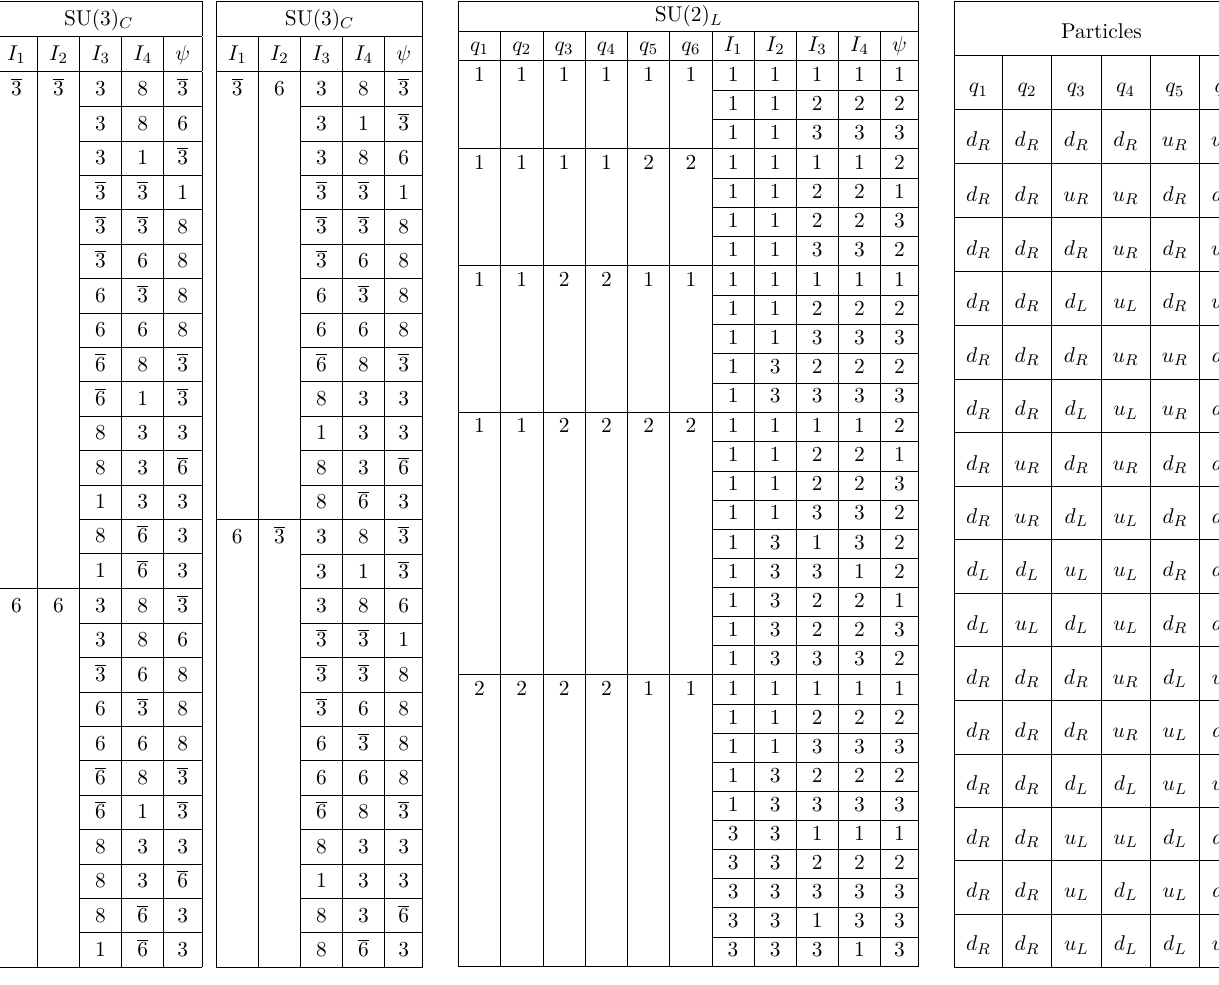
Table 4 . The possible quantum numbers of the fields in Topology-L-1. Once one determines the external quarks as, for example, q 1 , q 2 , q 3 , q 4 = d R , q 5 , q 6 = u R , the quantum numbers of the internal particles under SU(2) L × U(1) Y symmetry can be figured out from the middle and right